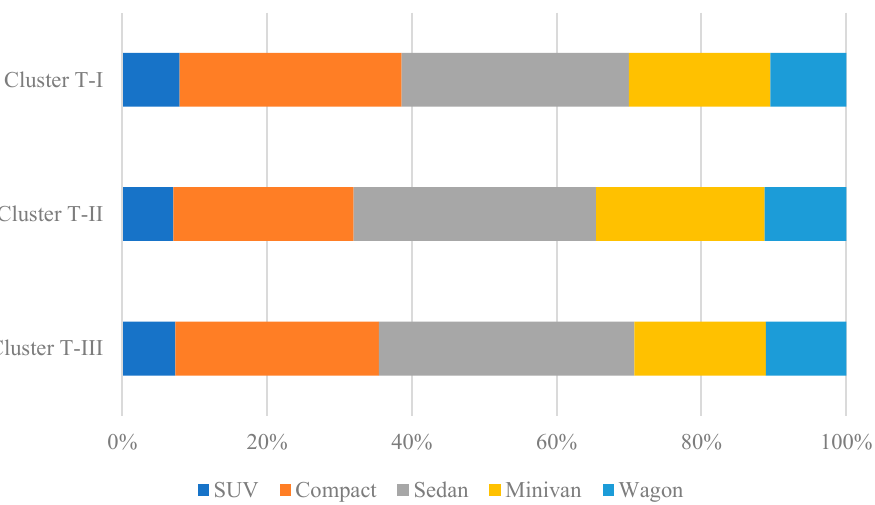
Figure 5. Percentages of HEVs by vehicle body type for each cluster.